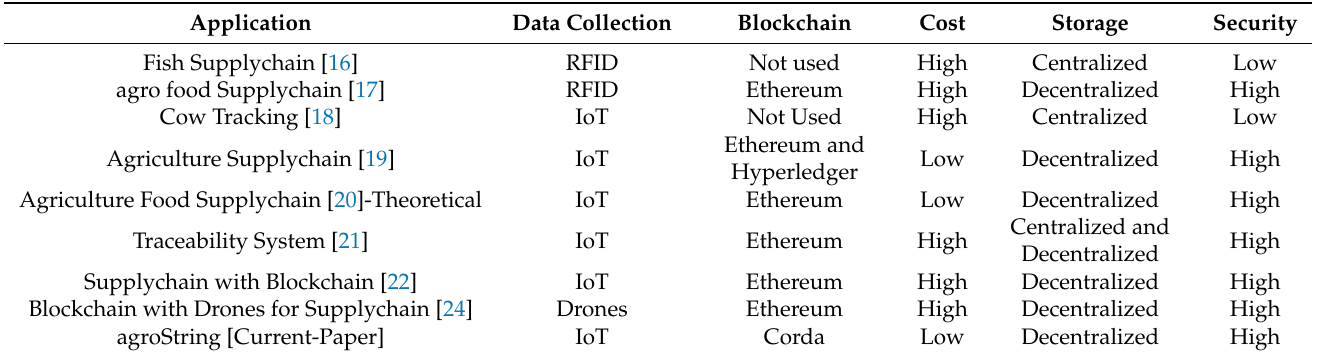
Table 1. Comparison of various agricultural data applications with